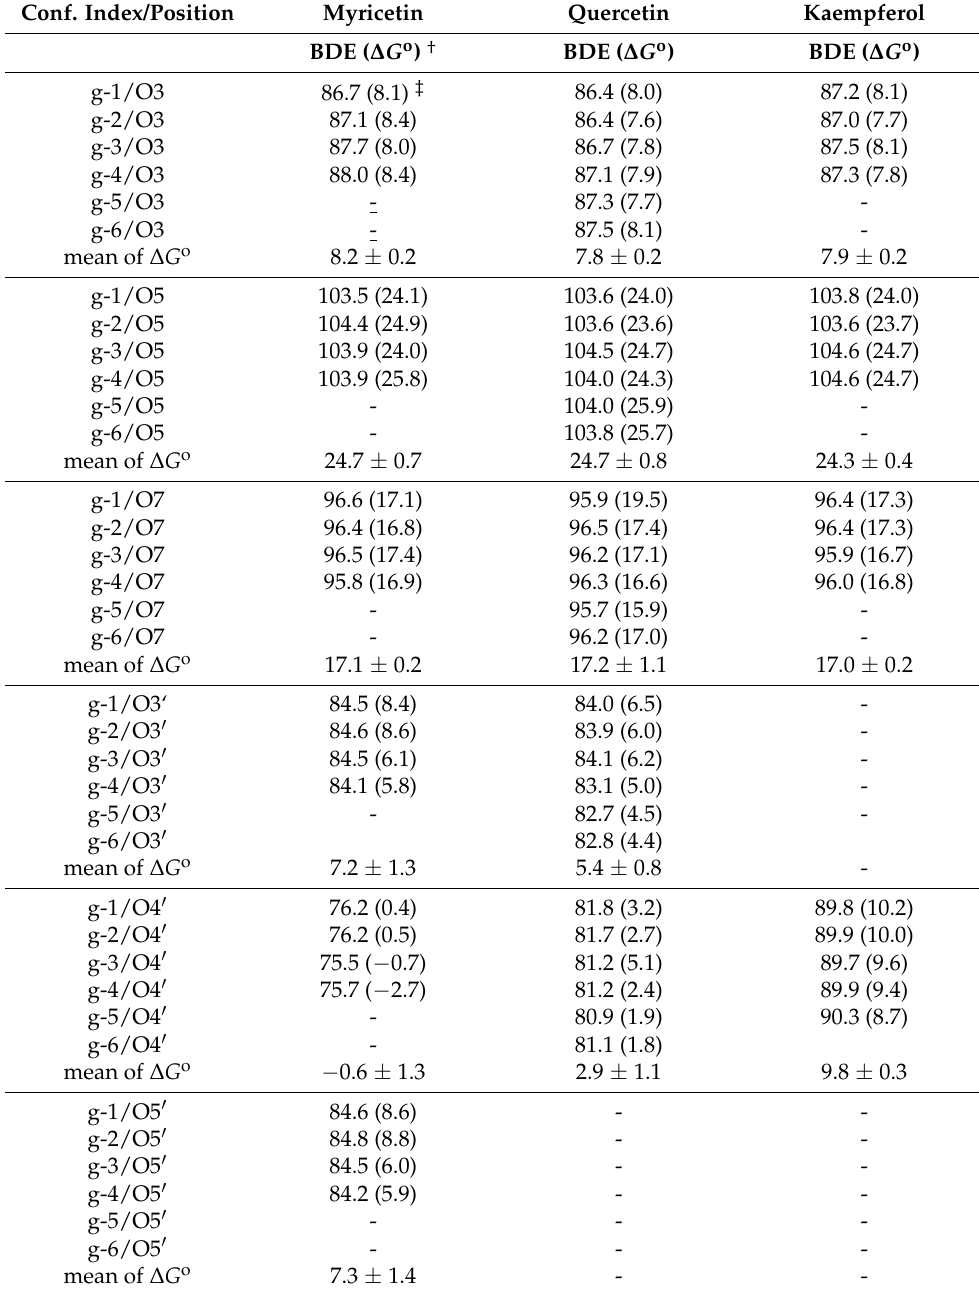
† BDE and ∆ G o are expressed in kcal/mol. ‡ Values in the parentheses represent ∆ G o